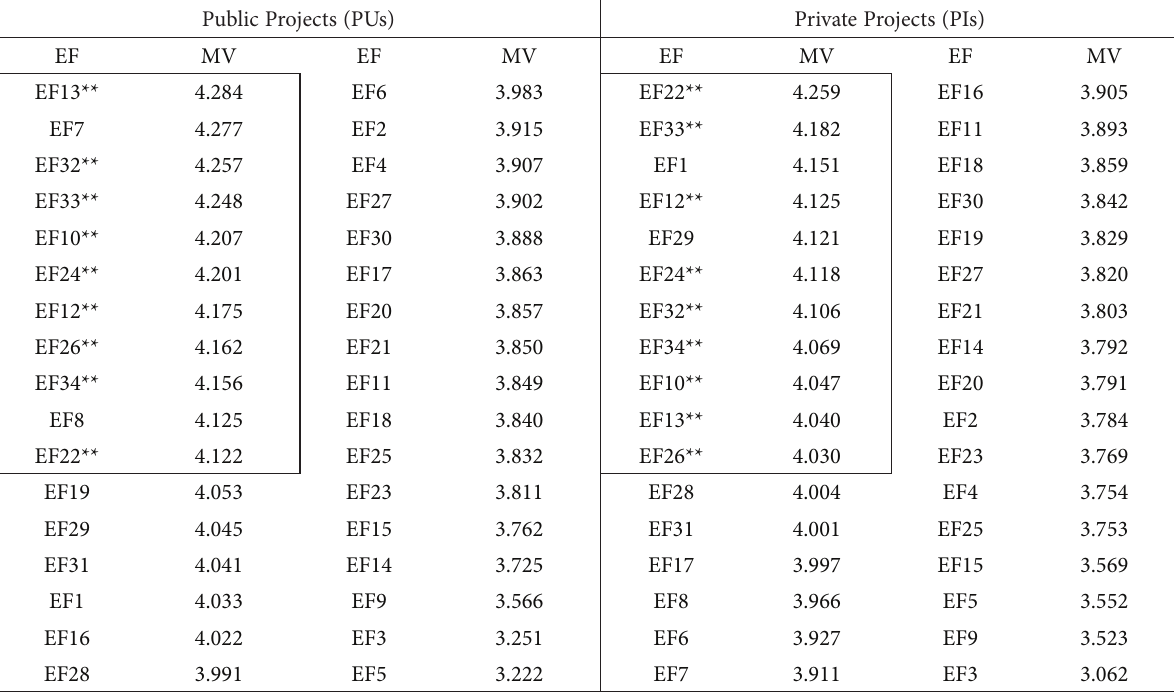
Table 4. A MV based list of factors in descending order Public Projects (PUs) Private Projects (PIs)